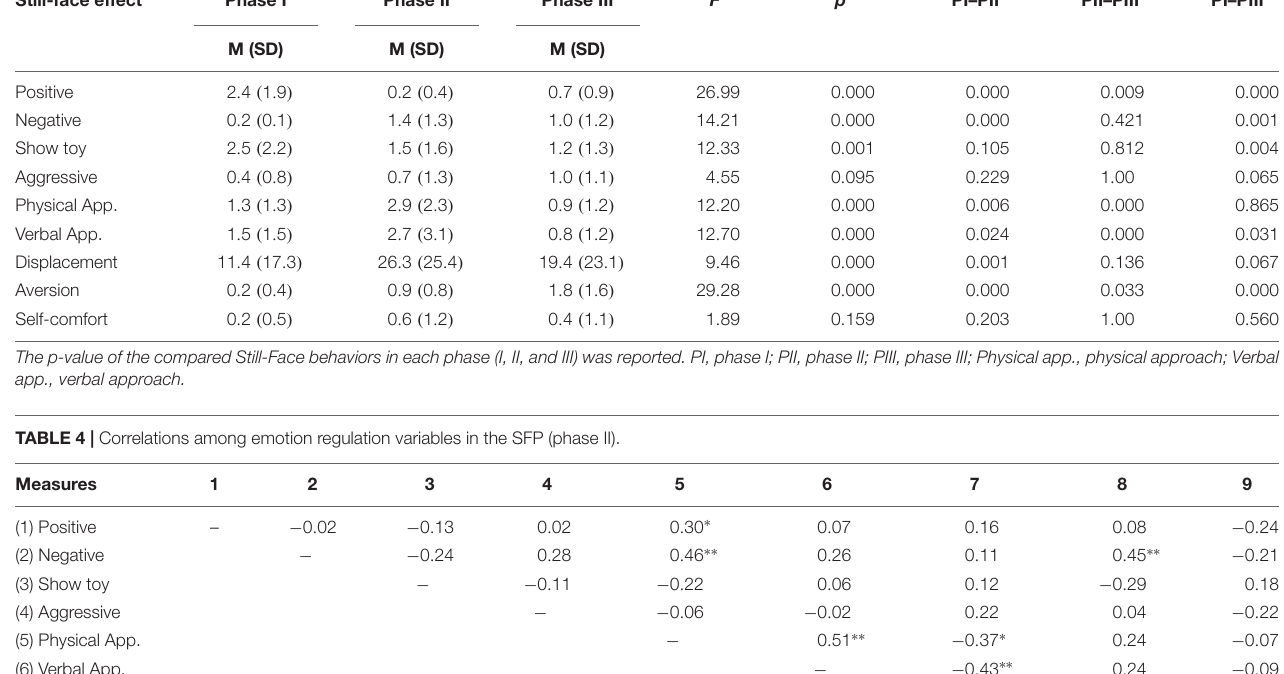
TABLE 3 | Comparison of the behavior scores and the different phases in the Still-Face task among infants. Still-face effect